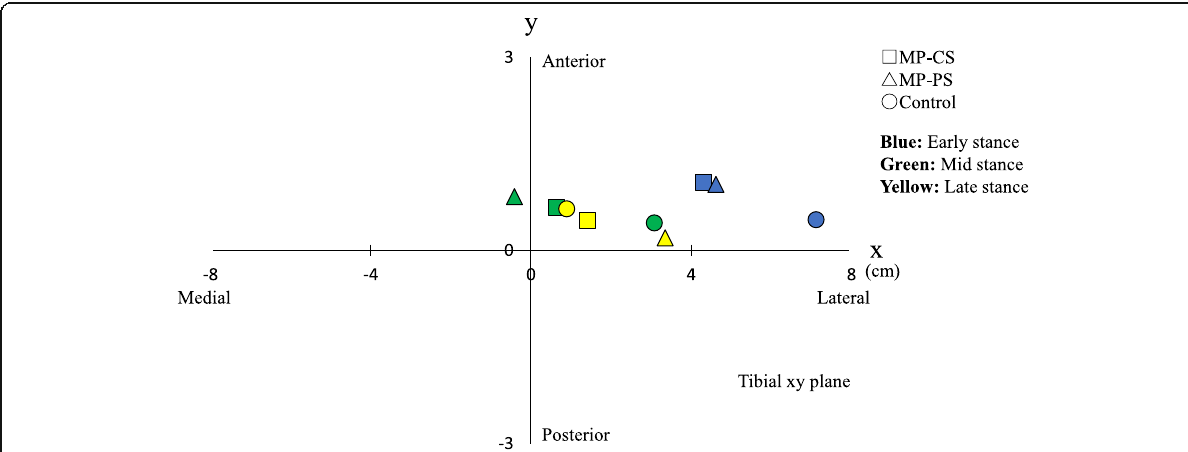
Fig. 3 Median COR during early stance, mid-stance, and late stance to swing phase of gait. Square, MP-CS group; triangle, MP-PS group; circle, control group. Blue indicates early stance, green indicates mid-stance, and yellow indicates late stance to pre-swing of gait. COR, center of axial rotation; MP, medial pivot; CS, cruciate-substituting; PS, posterior-stabilized